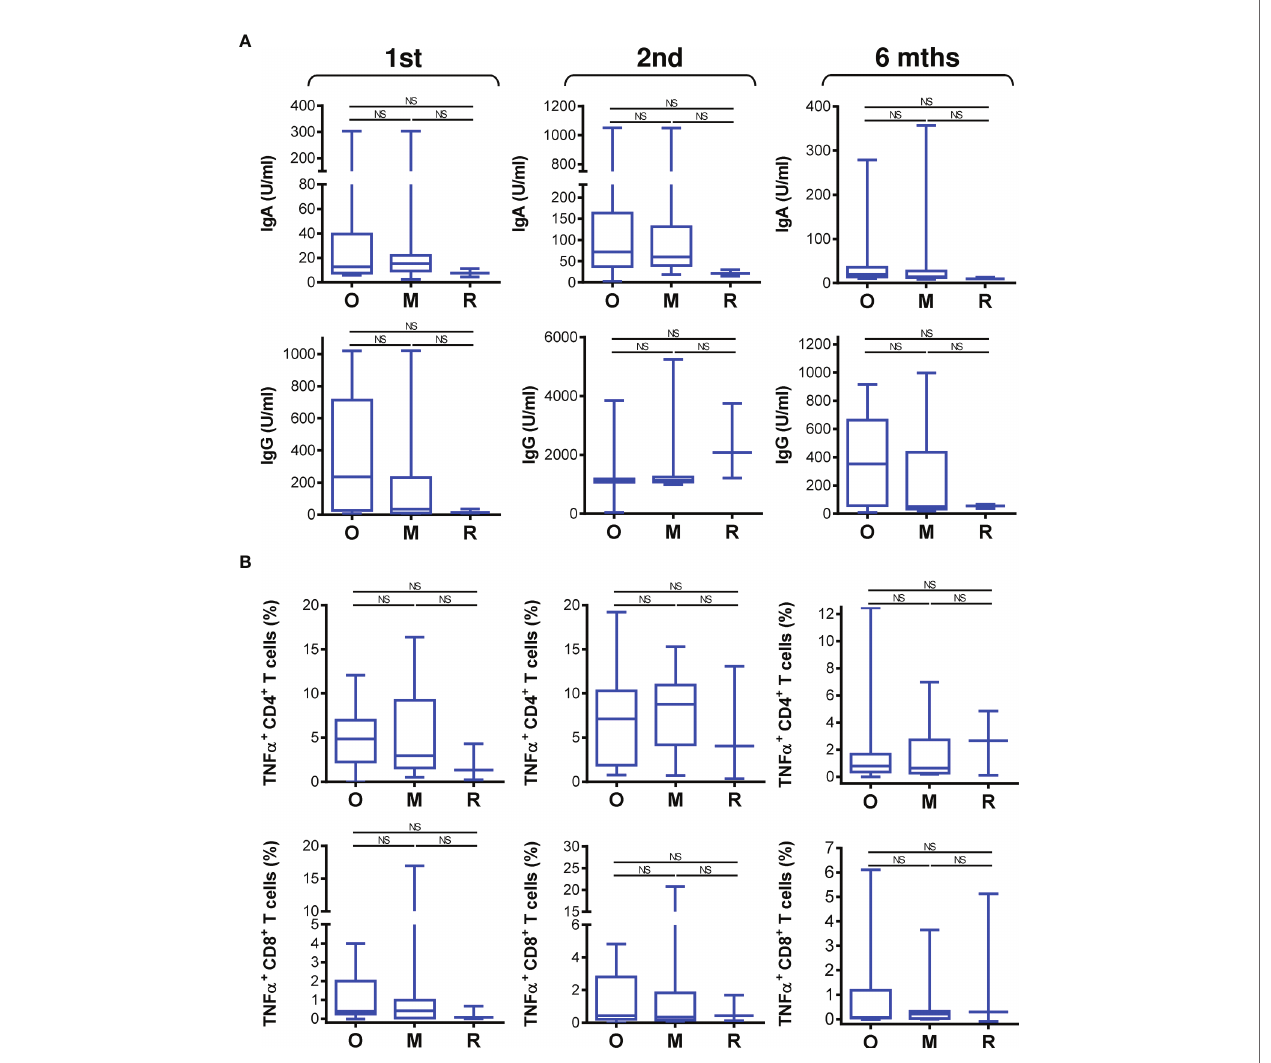
FIGURE 5 | The impact of biological therapy on SARS-CoV-2 spike glycoprotein-speci fi c humoral and cellular immunity during and after vaccination. (A) Patients were strati fi ed into 3 groups based on the type of biological therapy they received. The groups were 17 patients on anti-IgE therapy (O; omalizumab), 13 patients on anti-IL5 therapy (M, mepolizumab), and 3 patients on anti-IL5 (R, reslizumab) therapy. The serum levels (U/ml) of anti-RBD IgA ( top panels ) and IgG ( bottom panels ) antibodies before (1st) and 4 weeks (2nd) and 6 months (6 mths) after the second vaccine dose was administered. (B) The frequencies of peptide-reactive TNF a - producing CD4 + ( top panels ) and CD8 + ( bottom panels ) T cells in the strati fi ed groups in A before (1st) and 4 weeks (2nd) and 6 months (6 mths) after the second vaccine dose was administered. In (A, B) , box and whisker plots (2.5 – 97.5 percentile) are shown, and the signi fi cance of differences among the groups (O, M, and R) is indicated ( NS p > 0.05; n = 17 (O), 13 (M), or 3 (R); one-way ANOVA with Dunn ’ s